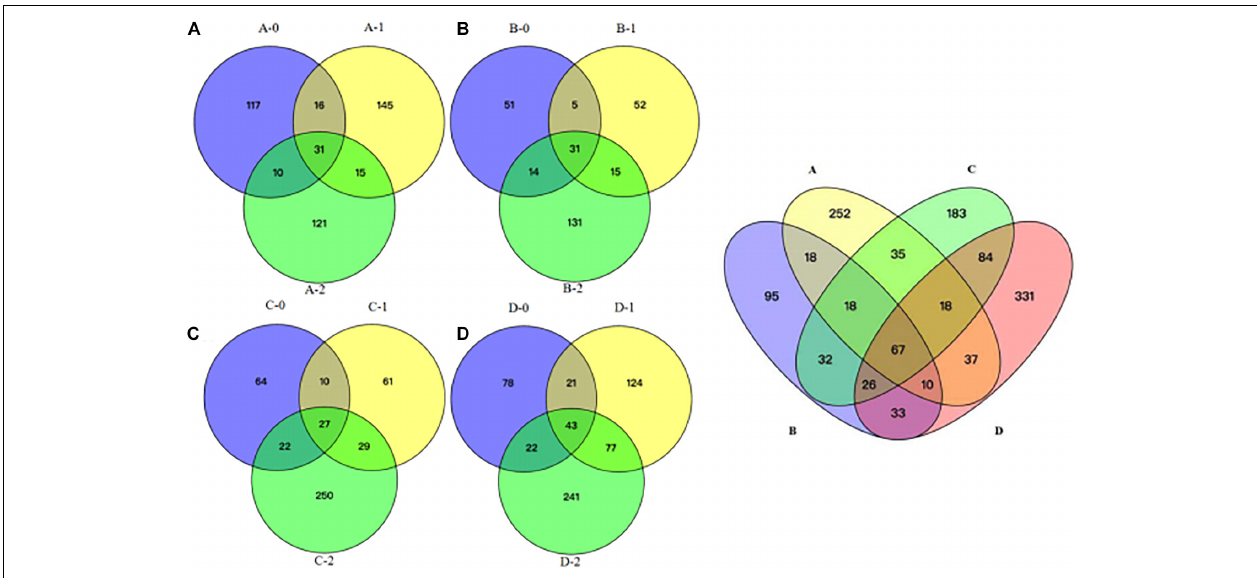
FIGURE 3 | Venn diagram showing the unique and shared OTUs among all the sediment samples. (A) location A; (B) location B; (C) location C; (D) location D; A, B, C, D: location; 0: 0.05 m depth sediment (surface); 1: 1 m depth sediment; 2: 2 m depth sediment.